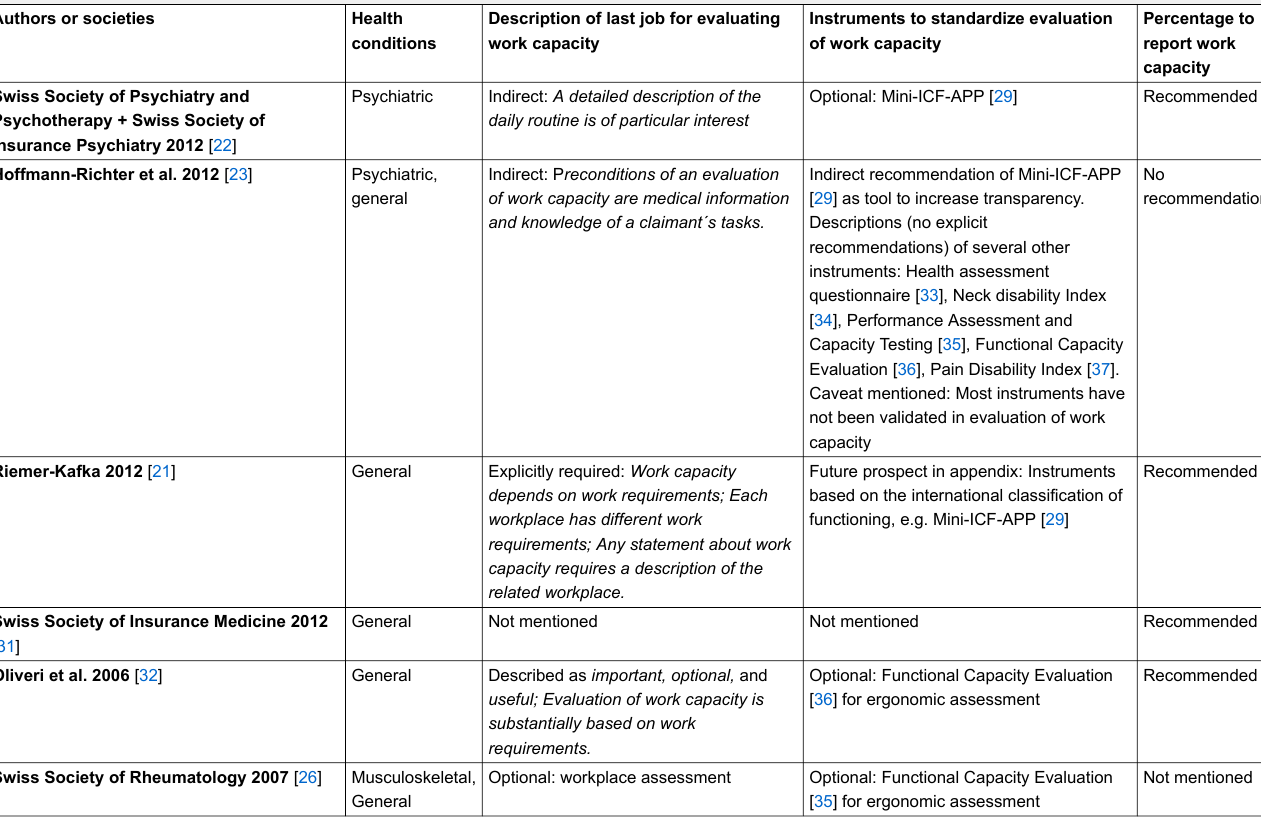
Table 5: Published guidance on psychiatric and general medical evaluations of work capacity. Authors or